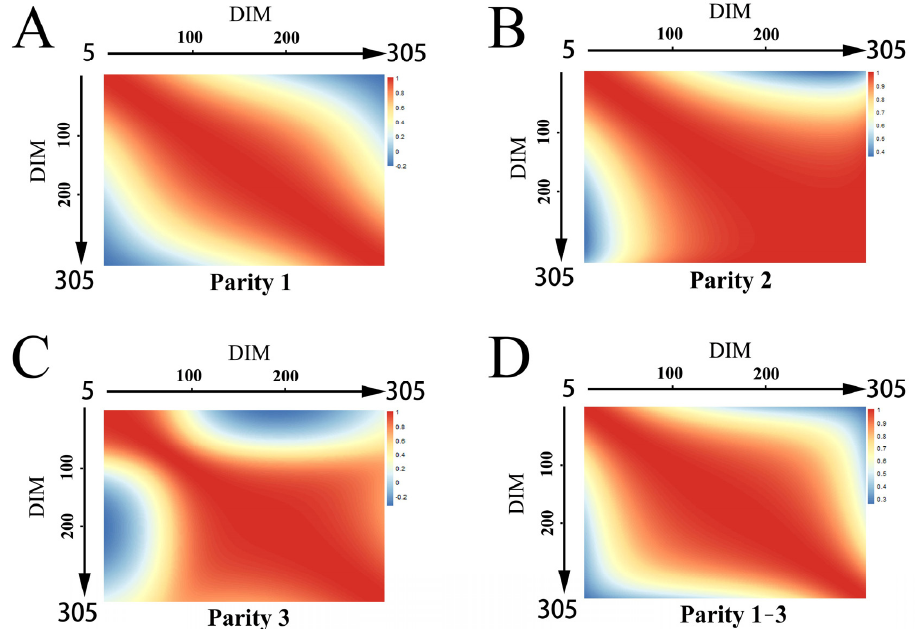
Figure 2. Genetic correlations of SCS in Holsteins in different DIM periods during lactation for different parities: ( A ) first parity; ( B ) second parity; ( C ) third parity; ( D ) first three parities. DIM: days in milk.